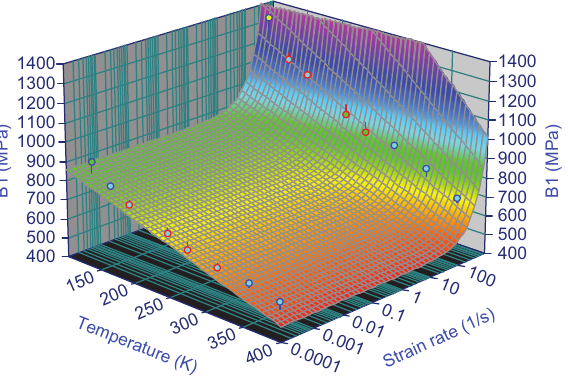
Figure 5 Change of hardening exponent n strain